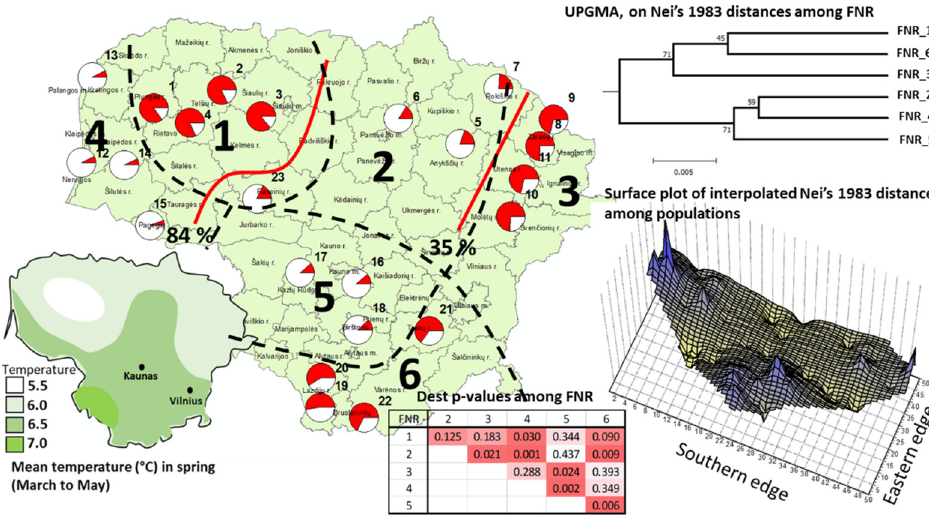
Figure 3. Population genetic structure based on STRUCTURE2.3.3 software Bayesian clustering and BARRIER boundaries of significant change in the allele frequency for the three cpSSR pt series loci. The pie charts show the relative proportions of the two STRUCTURE genetic clusters. The red solid lines indicate significant change in allele frequency modeled with Nei et al.’s [92] genetic distances among populations for two boundaries with the BARRIER software. The percentage of 1000 bootstraps returning these barriers is given at the BARRIER. The table below the main map shows the p -values of the pairwise differentiation indexes among the six forest natural regions (FNR, shown in large numbers on the main map). The lower-right map shows genetic structure as revealed by landscape shape interpolation of genetic distances among populations for the cpSSR loci (midpoints of edges by Delaunay triangulation, AiS software). The lower-left map shows the geographical variation in climatic index for spring phenology affecting the distribution of paternally inherited cpSSR haplotypes: mean daily air temperature during spring season (average for 1981–2011).